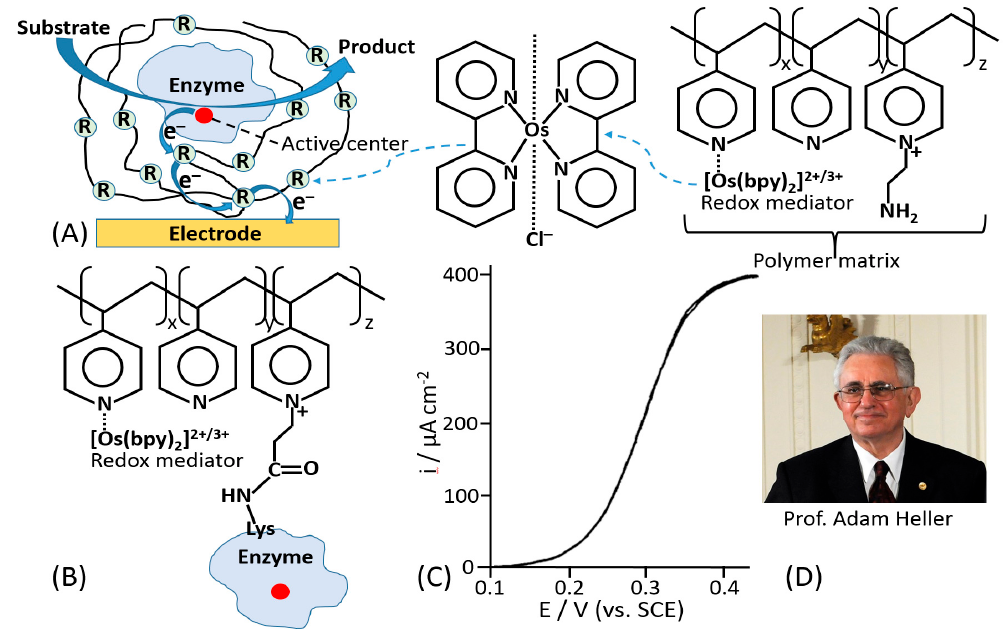
Figure 3. ( A ) An enzyme physically entrapped in a polymer operating as a redox matrix providing the enzyme electrical wiring by electron hopping through redox sites finally reaching an electrode conducting support. The redox-mediator sites are represented with [Os-(2,2'-bipyridine) 2 ] 2+/3+ - complex pendant at poly(vinylpyridine) matrix. ( B ) A similar system where the enzyme is covalently bound to the redox polymer. The systems have been pioneered by Prof. Adam Heller. They are exemplified with an enzyme oxidizing a substrate and generating anodic current mediated by the redox polymer irrespective of the enzyme orientation. ( C ) A cyclic voltammogram, showing a 400 μ A cm − 2 glucose diffusion limited current density reached at 40 mM glucose concentration with the wired-enzyme shown schematically in (B). The scan rate is 5 mV/s. ( D ) Prof. Adam Heller – the pioneer in the enzyme wiring according to many various approaches, particularly including systems exemplified in (A) and (B). (Part C was adopted from [44]; (D) the photo was adopted from Wikipedia, public domain).